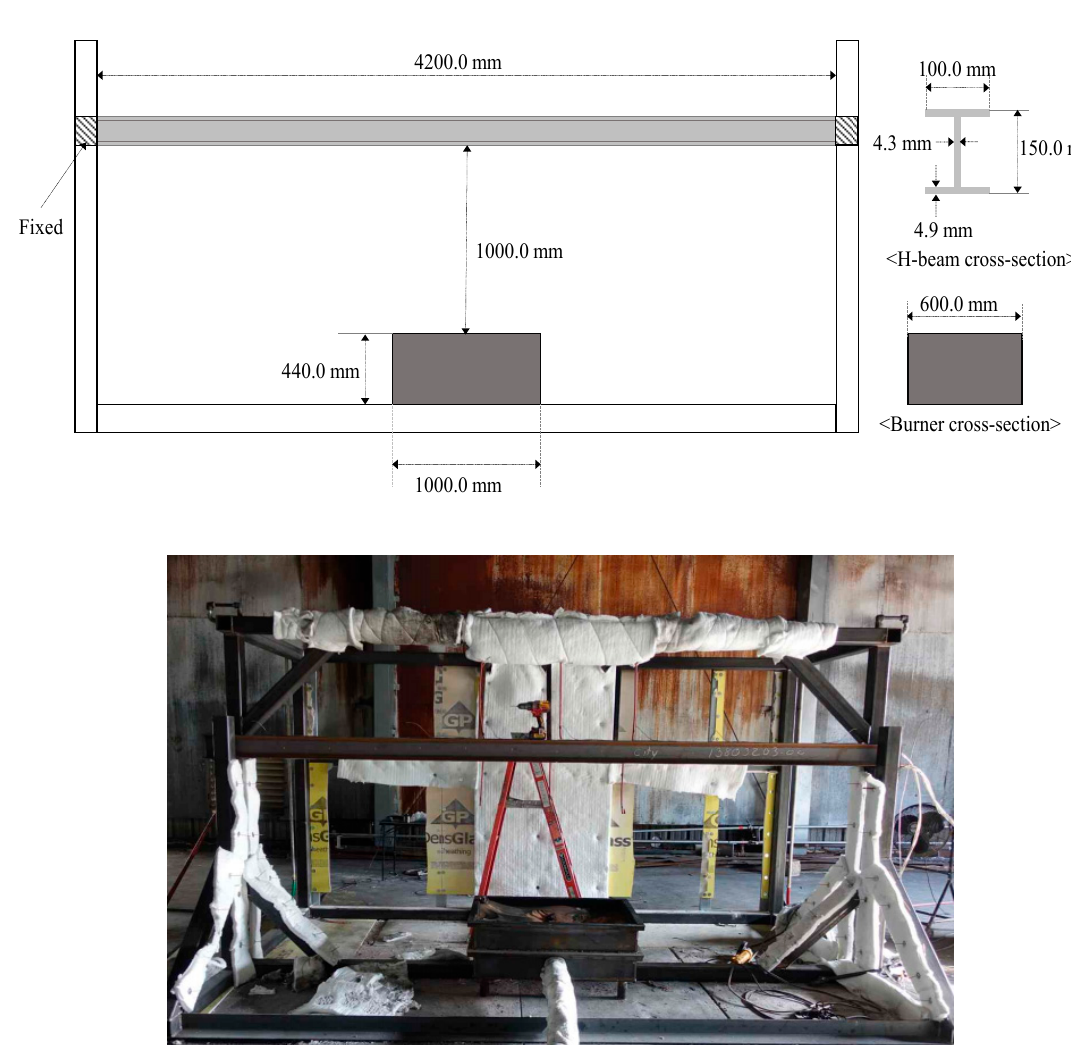
Figure 5. Experimental setup of the H-beam in the propane burner fire.